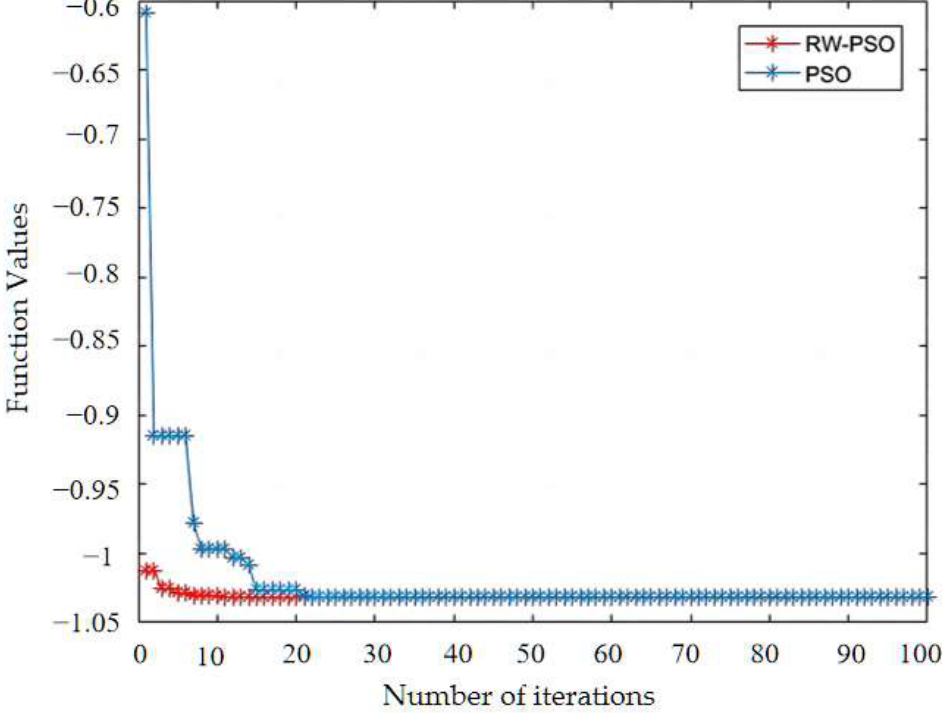
Figure 4. Iteration diagram of the test function of the PSO. Table 1. Parameter settings for the